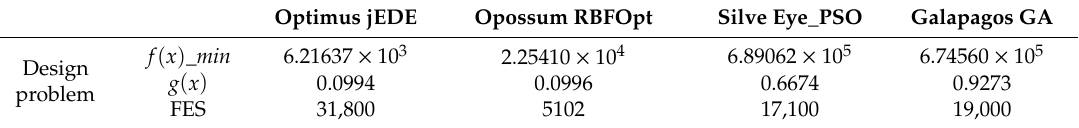
Table 4. Comparison of Optimus, Opossum, Silvereye, Galapagos (D = 70, NP = 50, termination: 30 min).